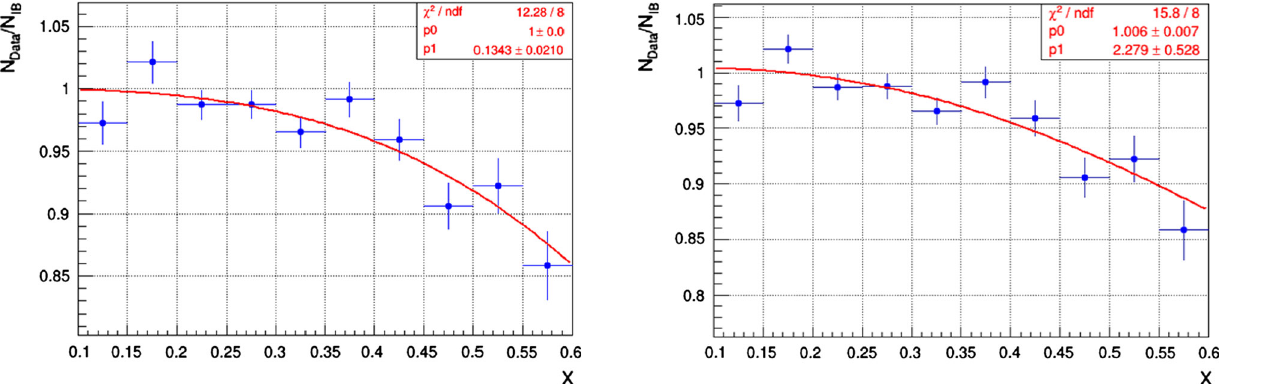
Fig. 6 N Data / N IB ratioasafunctionof x (bluepointswitherrors)and resultofthefitwith p signal ( x ) (redline).Forthedefinitionof p signal ( x ) , see text